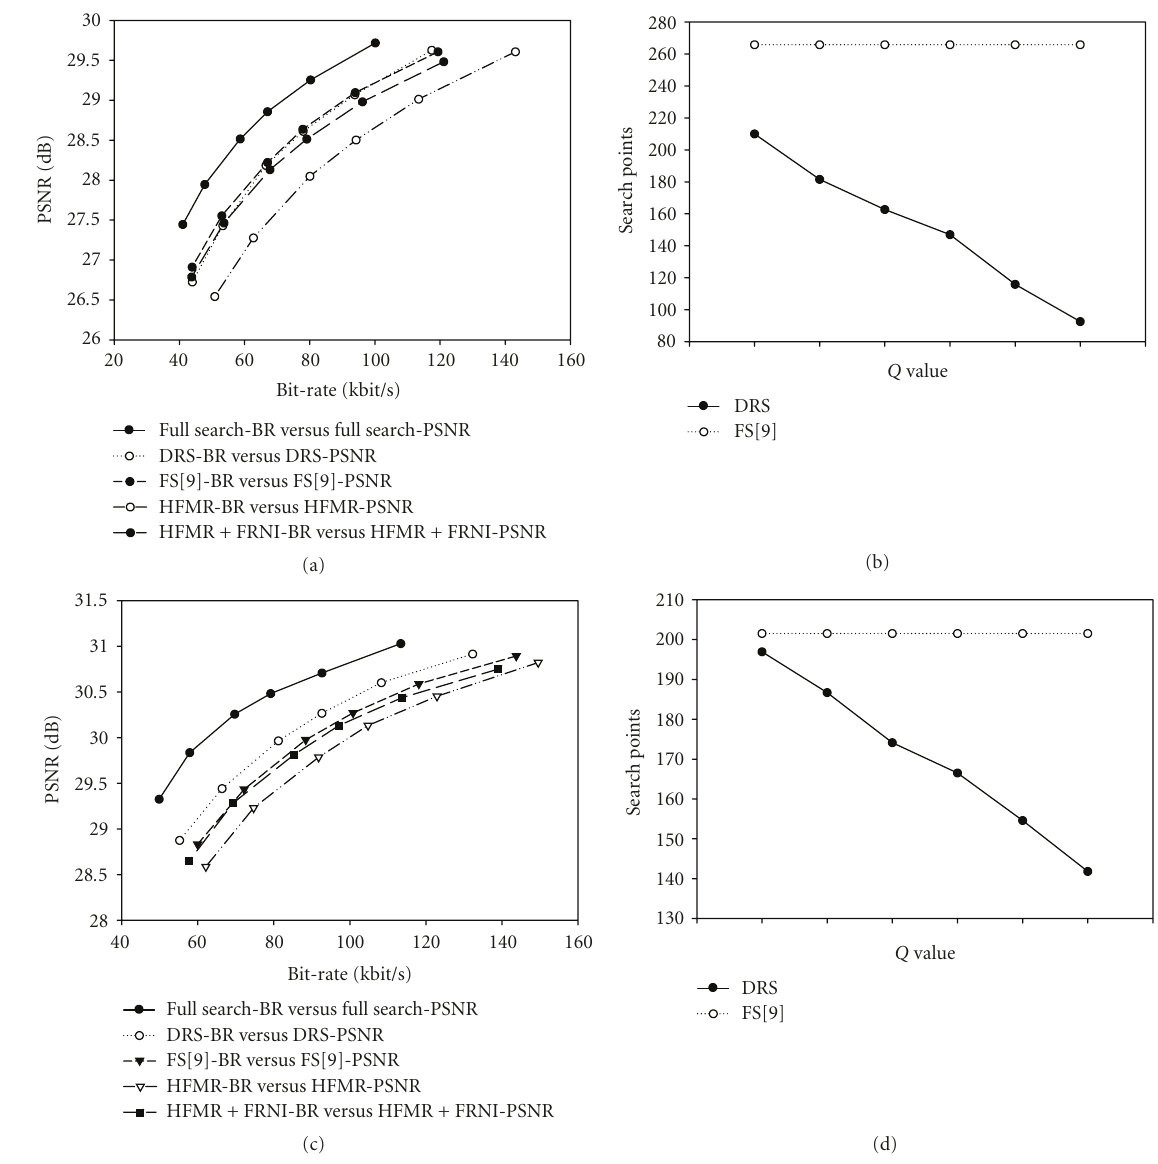
Figure 18: Simulation results for DRS. (a) The R-D curves of Foreman. (b) Average search points per frame for Foreman. (c) The R-D curves of TableTennis. (d) Average search points per frame for